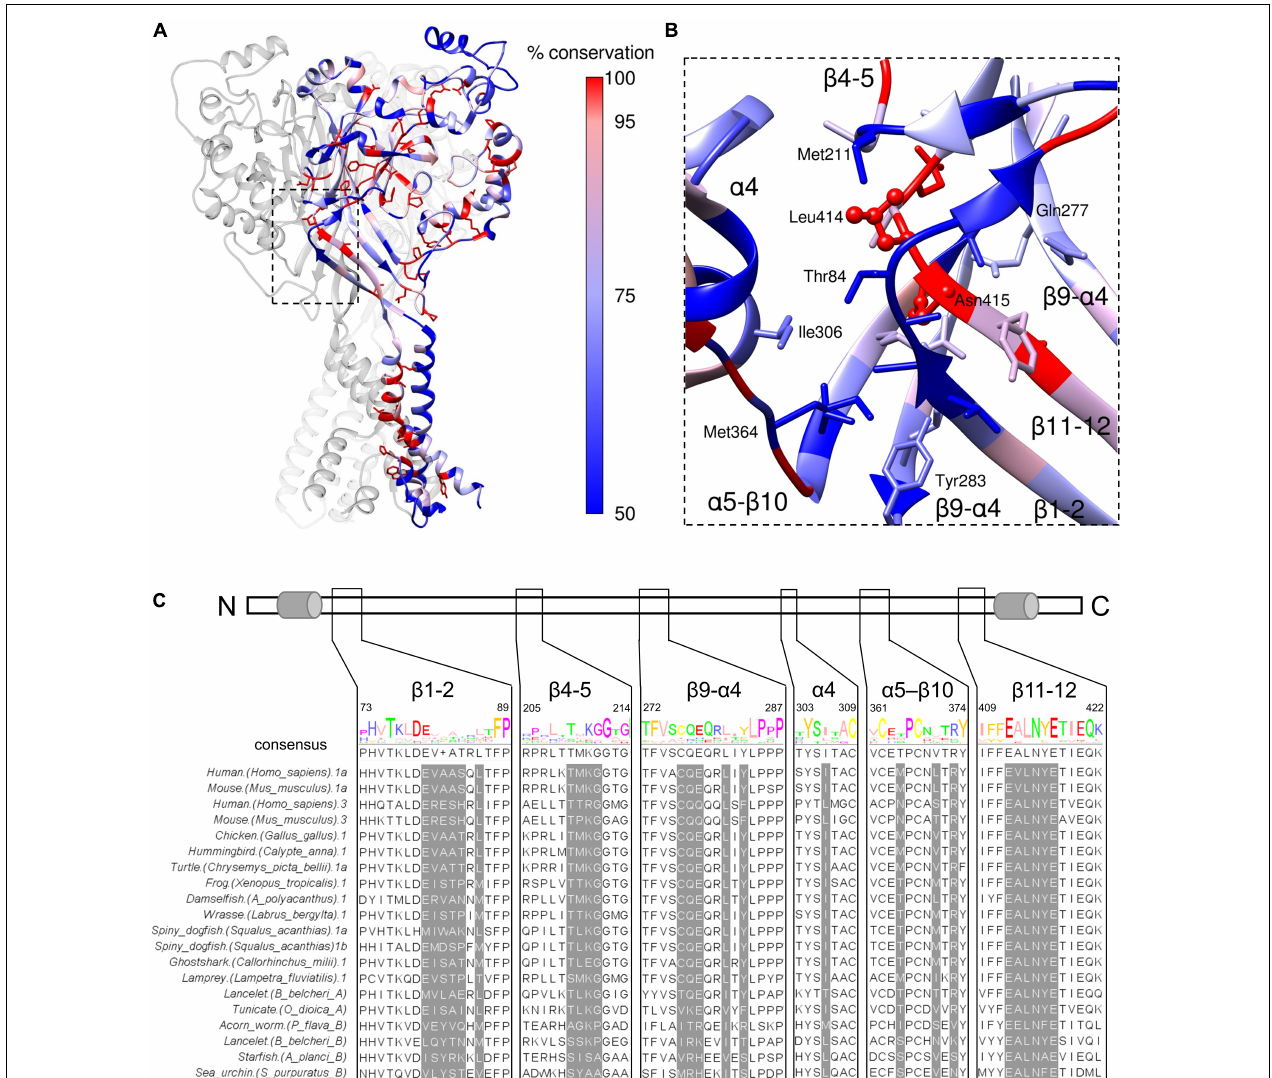
FIGURE 9 | β 11-12 linker is highly conserved while the surrounding region is not. (A) Resting state structure (PDB: 6VTL) with one subunit colored based on sequence conservation using sequence alignment from ASIC sequences in panel (C) . Side chains of completely conserved positions are shown. (B) Close up view of the boxed region in panel (A) using the same coloring. Any amino acids within 5 Å of Leu414 or Asn415 have side chains depicted. (C, upper) Schematic of ASIC1 linear peptide with cylinders indicating transmembrane domains 1 and 2. ( C , lower) Multi sequence alignment of the indicated ASICs. The amino acid regions shown from the alignment correspond to the segments in panel (B) . Positions highlighted in gray are within 5 Å of Leu414 or Asn415 and have side chains depicted in panel (B)